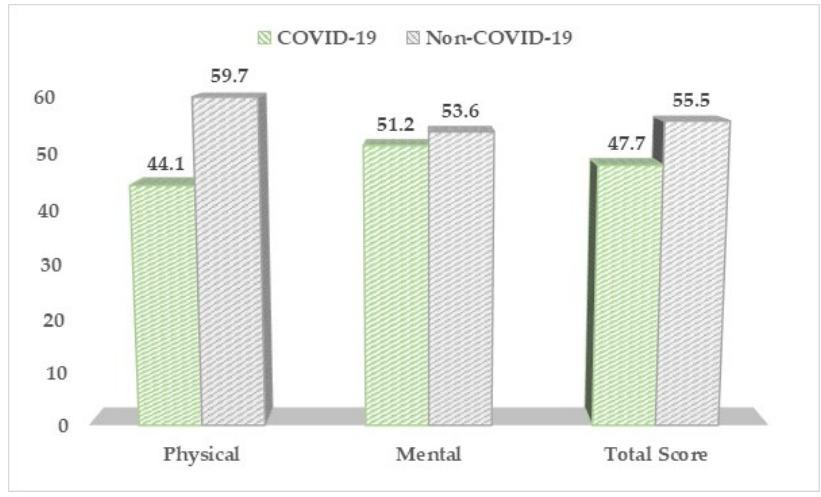
Figure 3. SF-12 questionnaire results between COVID-19 positive and negative pregnant women.